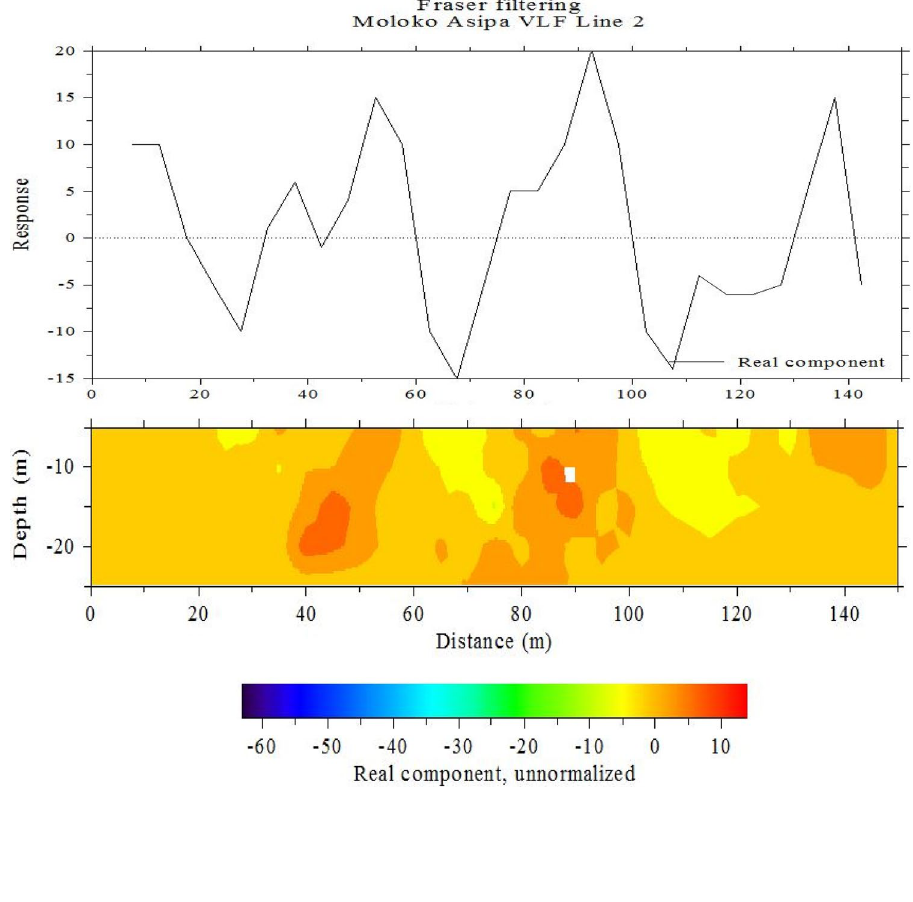
Fig. 3 Fraser and Karous–Hjelt representation for traverse 1